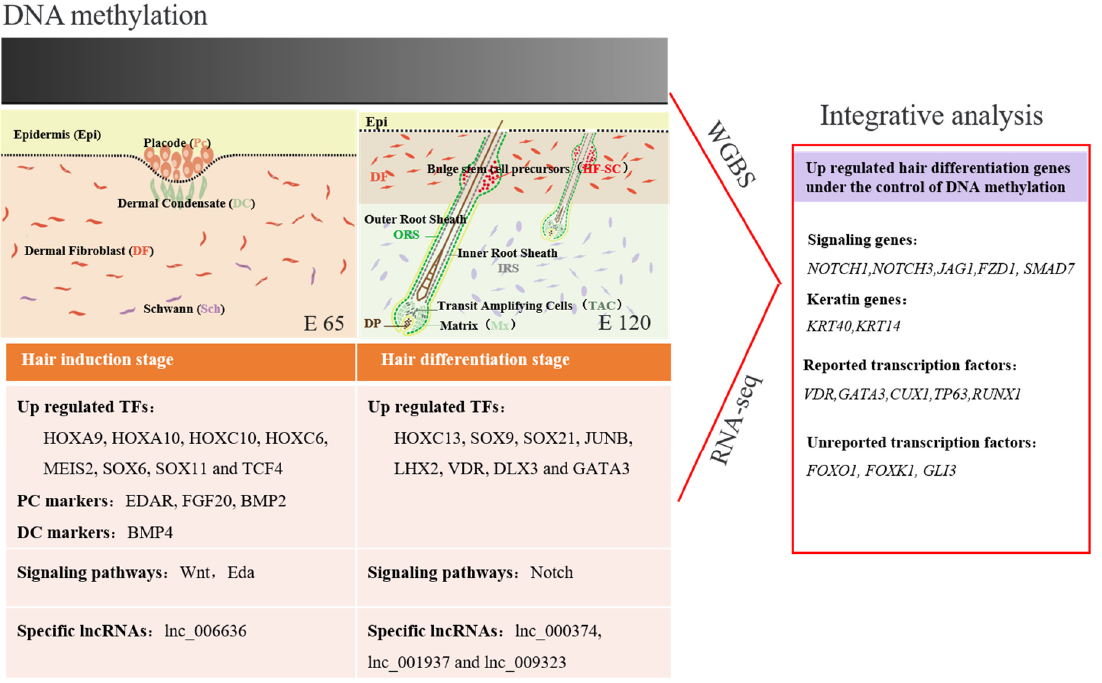
Figure 12. Integrative analysis of the methylome and transcriptome reveals the regulatory mechanisms of hair follicle morphogenesis in Cashmere goat. The darker color represents a higher DNA methylation level.